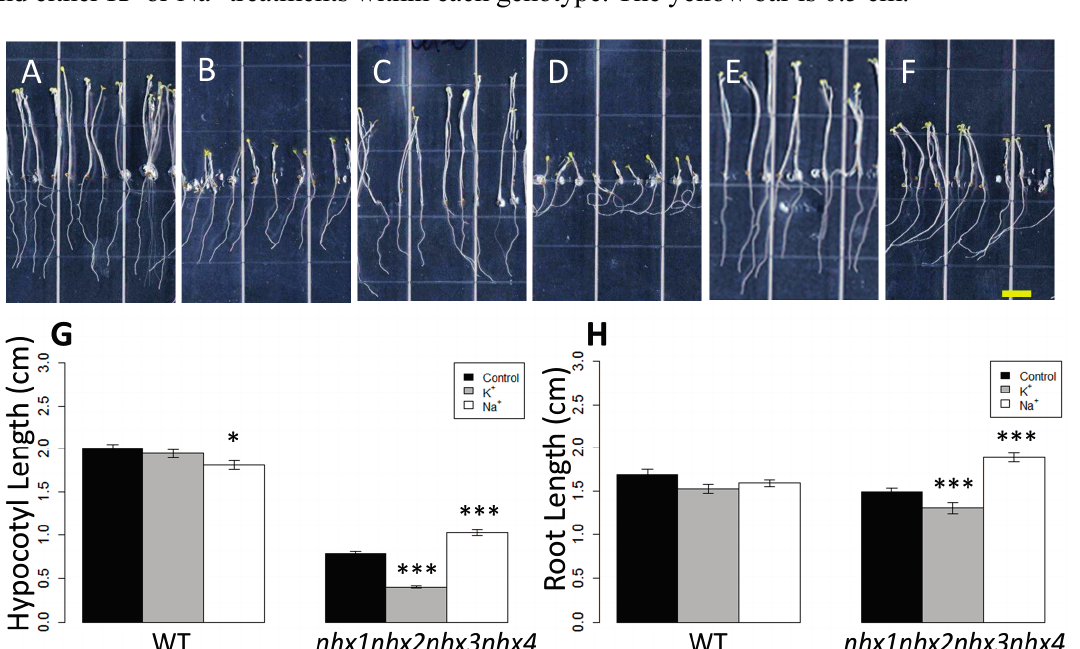
Figure 2. Etiolation response of the knockout nhx1nhx2nhx3nhx4 . Etiolated wild-type ( A , C , E ) and nhx1nhx2nhx3nhx4 ( B , D , F ) seedlings grown for 11 days in the dark on either 30 mM K + ( C , D ) or 30 mM Na + media ( E , F ). No significant difference in hypocotyl or root growth was noted in the wild-type; however, in nhx1nhx2nhx3nhx4 , root and hypocotyl growth was significantly inhibited in seedlings grown in 30 mM K + and increased in those grown in 30 mM Na + , as compared to control media. Quantification of hypocotyl ( G ) and root ( H ) growth normalized relative to growth on control media (1 mM Na + and 1 mM K + ). nhx1nhx2nhx3nhx4 displayed left-handed root skewing when grown on media containing 30 mM K + ( D ), but not 1 mM K + ( B ). Values represent the mean ± SE ( n = 29). * p ≤ 0.05, *** p ≤ 0.001; p -values reflect significant differences between control and either K + or Na + treatments within each genotype. The yellow bar is 0.5